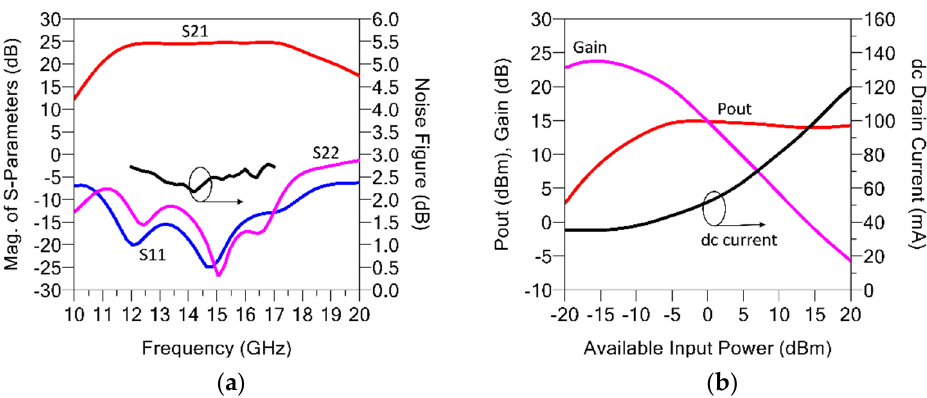
Figure 5. Ku-band SCFE measured performance in Rx mode. ( a ) Measured S-parameters and noise figure; ( b ) output power, gain and DC drain current as a function of the available input power ( b ). Bias and control voltages are set according to Table 1.